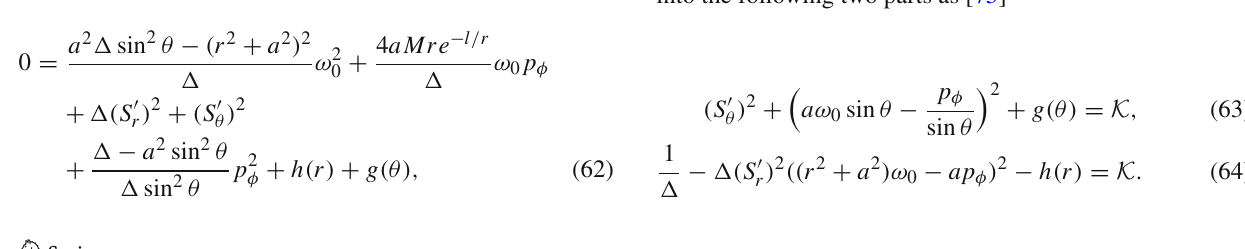
into Eq. (59) and get the following